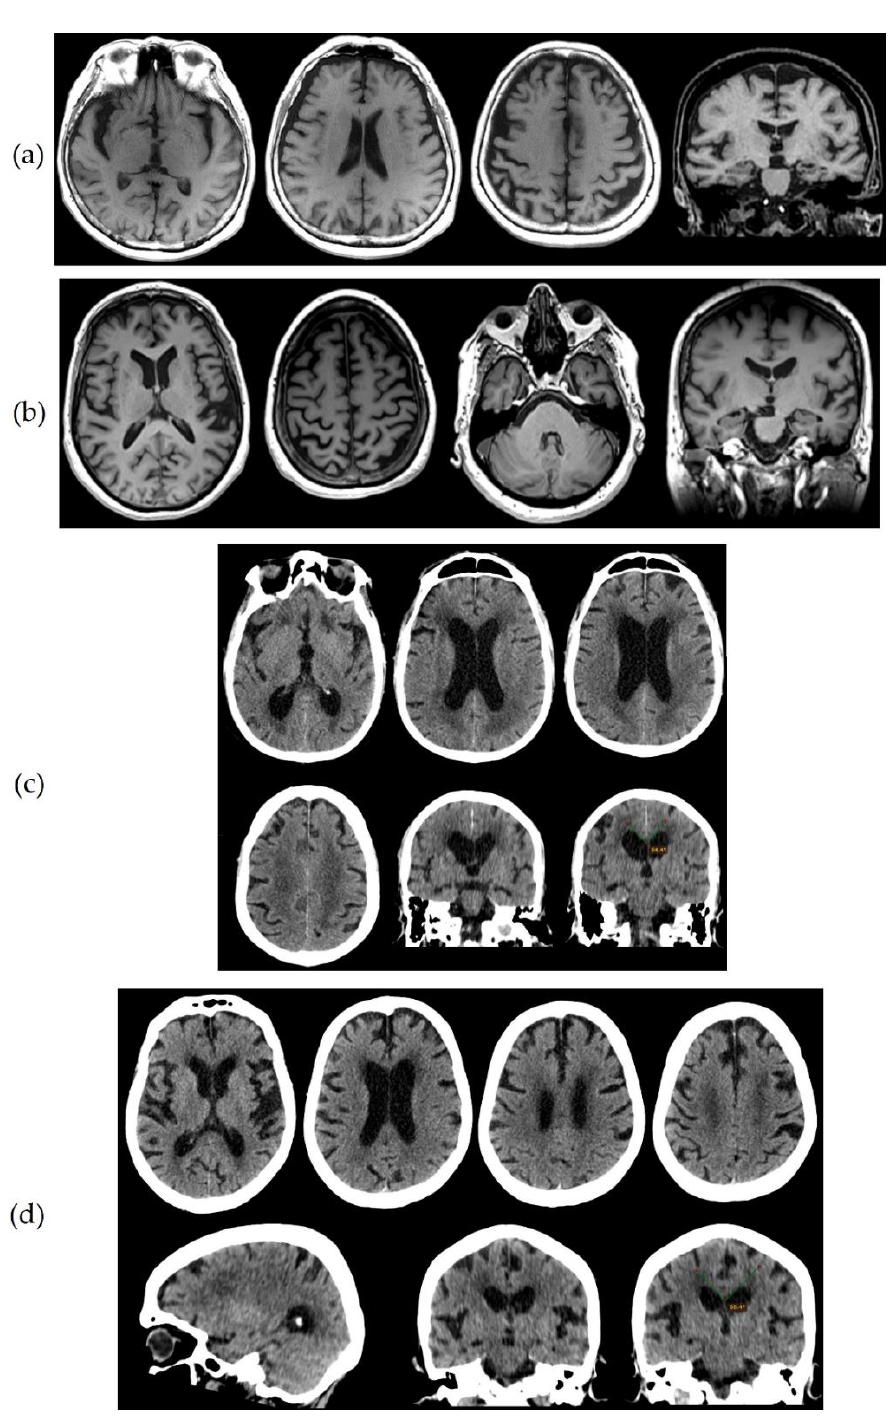
Figure 2. ( a ) T1 Magnetic Resonance Imaging (MRI) sequences of patient 1. Frontal (mainly), frontoparietal, perisylvian, and left hippocampal (grade 3) atrophy is observed. ( b ) T1 MRI sequences of patient 2. Atrophy in the left posterior perisylvian and parietal area is observed with preservation of the hippocampus. ( c ) Computerized tomography (CT) scan of patient 3. Some degree of frontal and parietal atrophy is seen. The white matter shows decreased density consistent with subcortical small vessel disease, in addition to periventricular caps. The parietal convexity is tight, the callosal angle is 84.4° and the Evans index has been calculated to 0.36. ( d ) CT scan of patient 4. Frontal (mainly) and parietal asymmetric atrophy are observed. Although the parietal convexity is not tight, the callosal angle is 88.4° and the Evans index has been calculated to 0.38. Decreased density of the white matter at centrum semiovale is noted, consistent with small vessel disease, with additional periventricular caps.